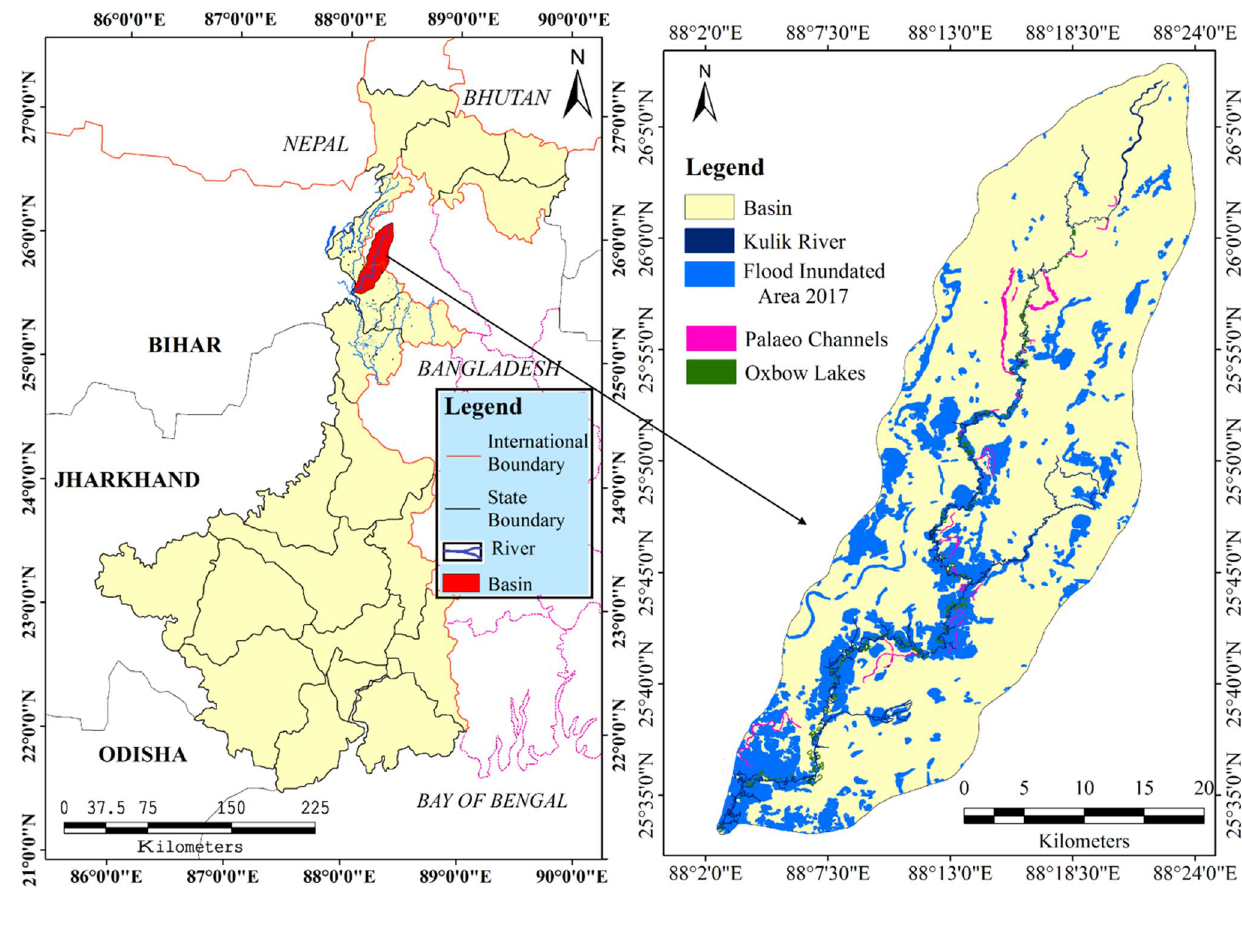
Fig. 1 Location of the study area Table 1 Data source and data type used in the research